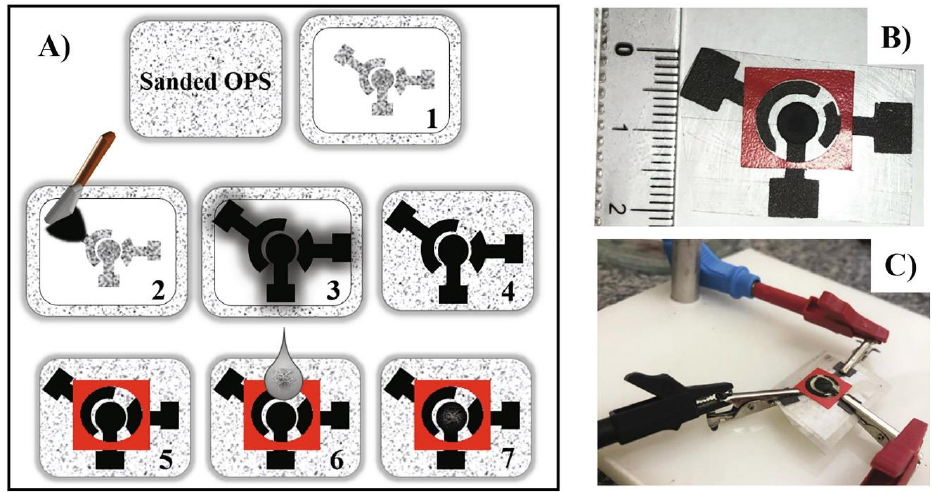
Figure 9. ( A ) Schematic representation of SPE preparation and modification. ( B ) Image of the final device. ( C ) Image of the final SPE connected to the potentiostat. Reprinted with permission from Elsevier from Ref. [124].